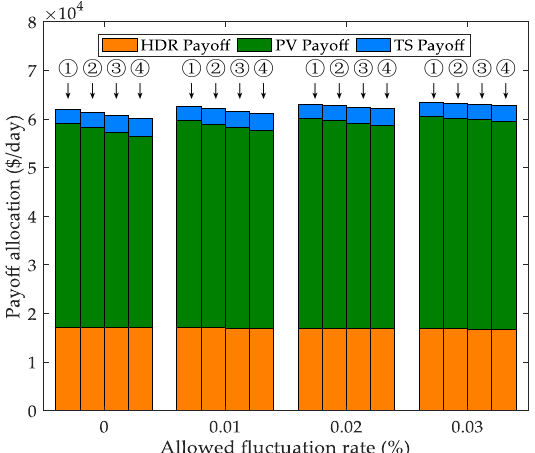
Figure 10. The payoff allocation in the grand coalition.